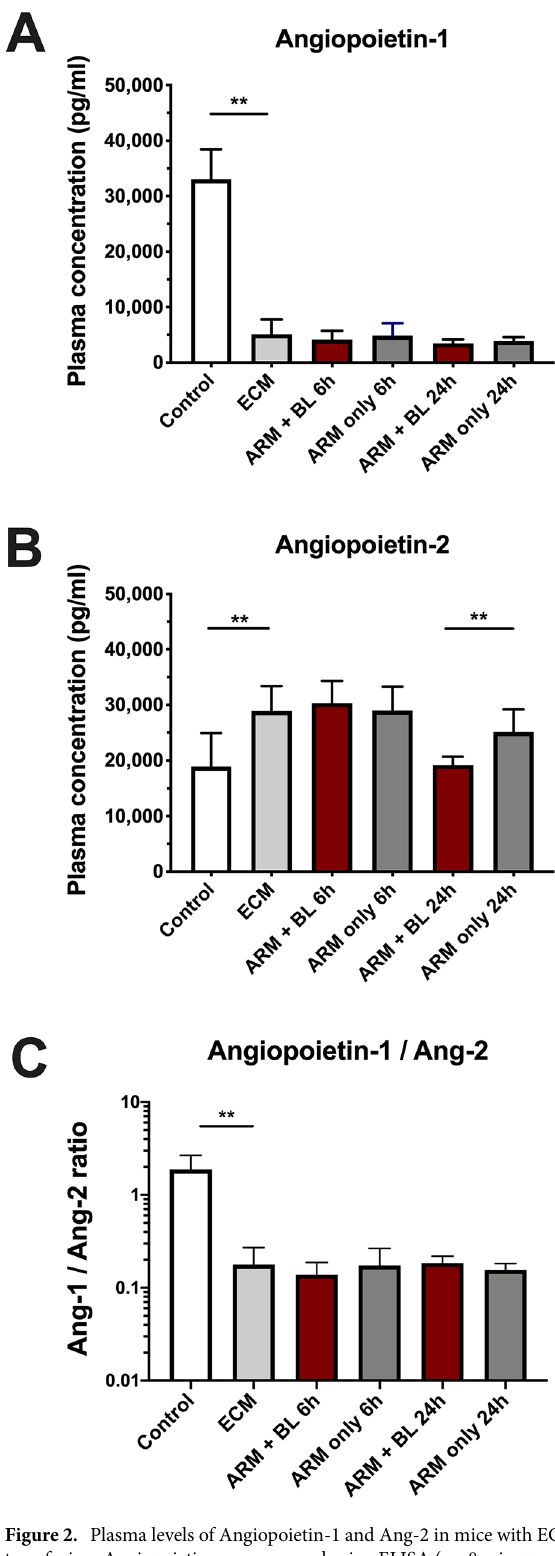
Figure 2. Plasma levels of Angiopoietin-1 and Ang-2 in mice with ECM treated with artemether with or without blood transfusion. Angiopoietins were assessed using ELISA ( n = 8 mice per group). Levels of Ang-1 ( A ) were decreased by 85% in mice with ECM in relation to uninfected controls (P < 0.0001). Treatment with ARM only or ARM + BL did not change Ang-1 levels within 24 h. Levels of Ang-2 ( B ) were elevated by a mean 52% in mice with ECM in relation to uninfected controls (P = 0.0038). With blood transfusion after 24 h, concentration of Ang-2 decreased back to normal levels, whereas in ARM only treated mice levels remained high (P = 0.0090). The ratio of Ang-1 to Ang-2 ( C ) was decreased tenfold in mice with ECM compared to uninfected controls (P = 0.0002) and was not changed by ARM only or ARM + BL treatments within 24 h. Data are shown as mean ± standard deviation and Student t-test was performed for statistical analyses comparing two